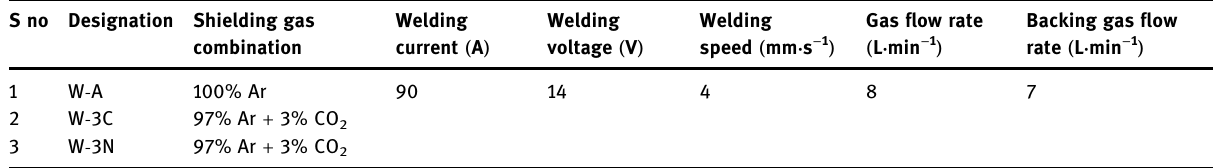
Table 1: Designation of specimens and GTAW process parameters used to weld AISI 310 SS and AISI 2205 DSS S no Designation Shielding